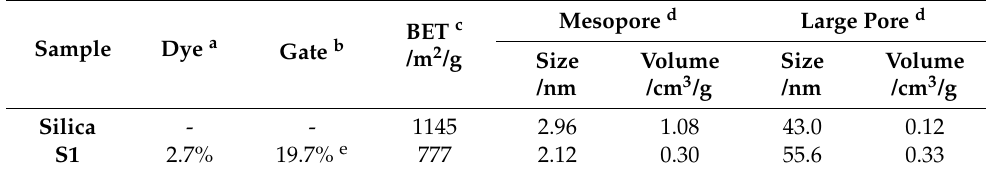
Figure 4. N 2 . adsorption–desorption isotherms of the starting MCM-41 ( a ) and the S1 solid ( b ). The curves and symbols in black and red colors correspond to the N 2 adsorption and desorption branches of the isotherms, respectively. A schematic representation of the pores filled through capillarity at medium (P/P 0 ~ 0.3; intraparticle mesopores) and high (P/P 0 > 0.9; interparticle voids) relative pressure values are included. Table 1. Selected physical and analytical